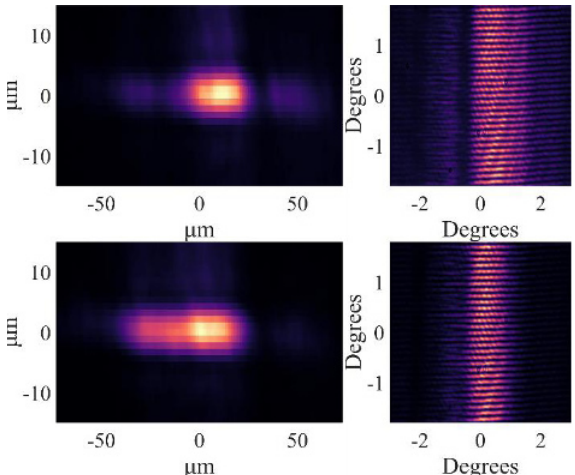
Fig. 4. Control of MQWL spatial mode width and corresponding interference pattern (modified from